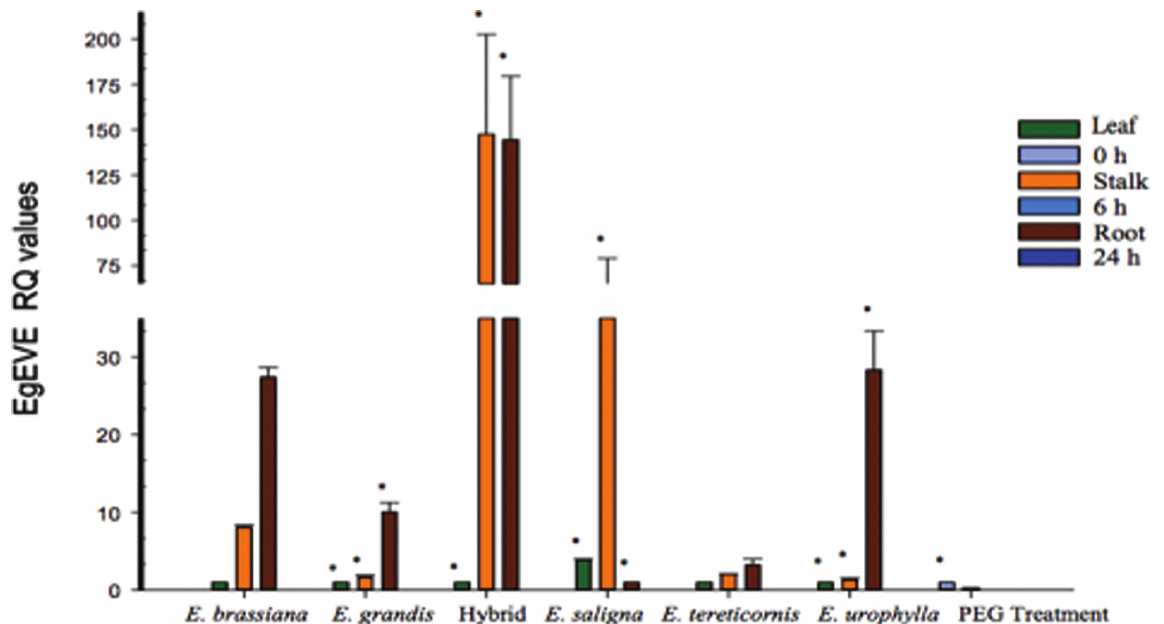
Figure 3 - Transcriptional profile of EgEVE in three tissues from five Eucalyptus species and one interspecific hybrid using RT-qPCR. Asterisk indicates differential expression (*p (cid:4) 0.05, ANOVA followed by LSD